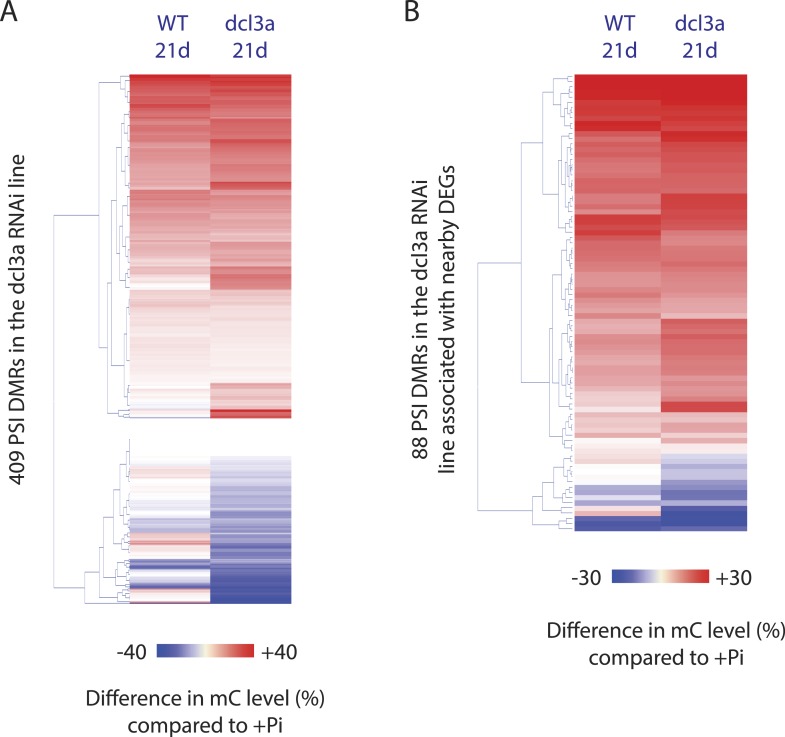
Identification of PSI DMRs in the DCL3a RNAi line.